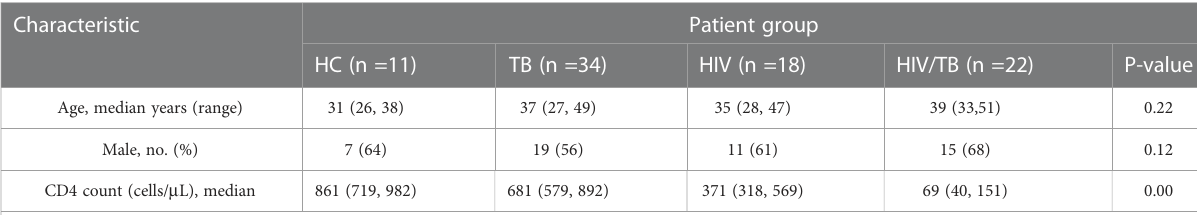
TABLE 2 General information of subjects in the study of function analysis for function analysis. Characteristic